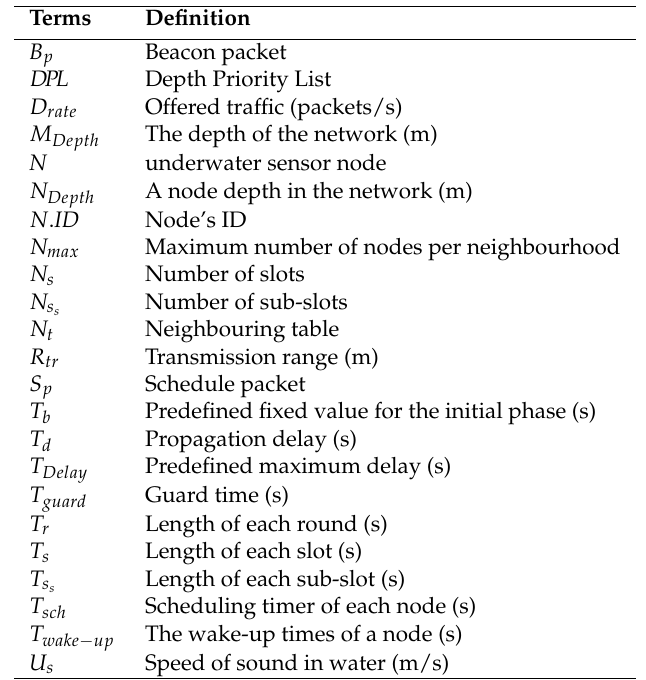
Table 1. Notations.